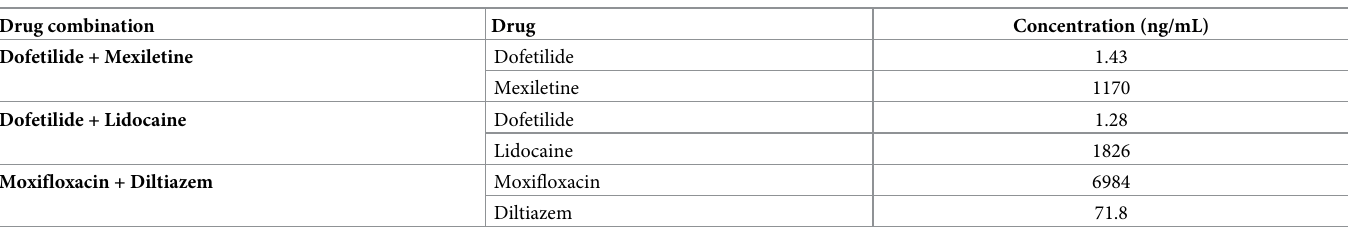
Table 2. Representative plasma drug concentrations in Study